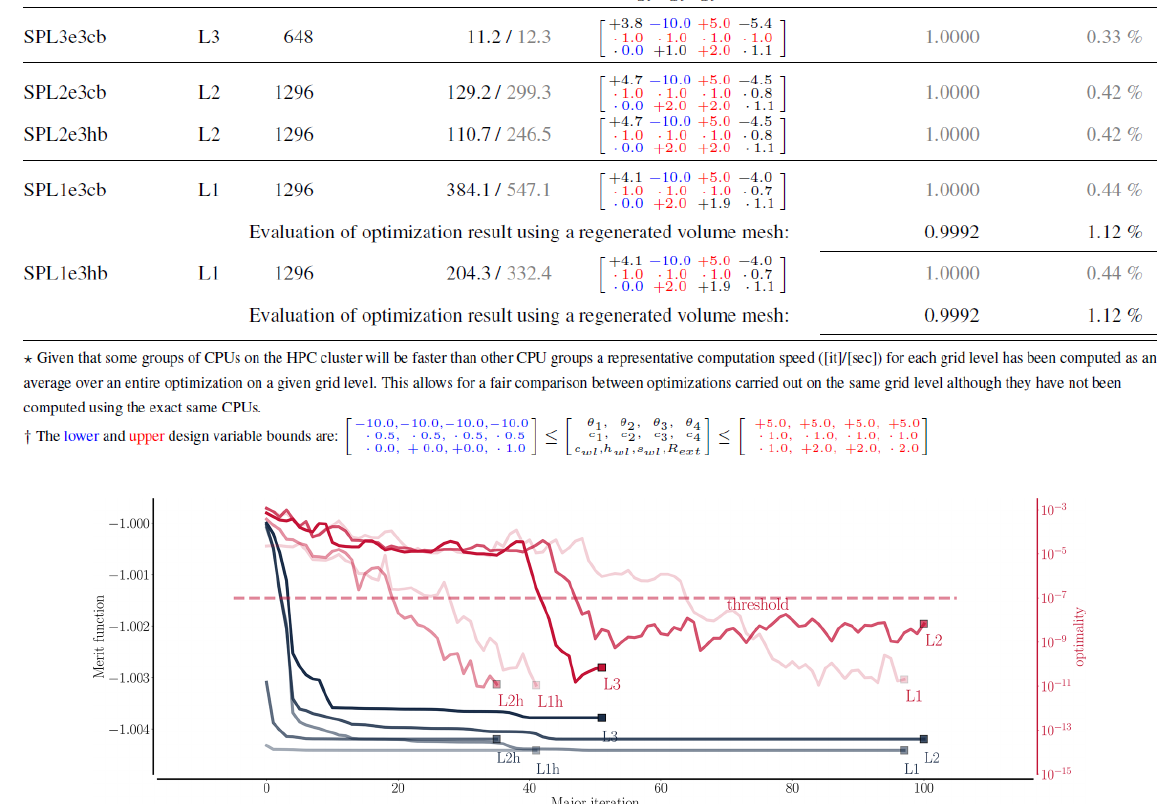
Figure 10. Merit function (black, left y axis) and optimality (red, right y axis) for shape optimizations (Table 6) on mesh levels L3, L2, and L1 using finite difference step size h = 10 − 3 . The SPL1e3hb is a hot-started optimization on L1 where the result from L2 is used as the starting point. The SPL2e3hb correspondingly uses the L3 result as the starting point. All other optimizations start from a straight